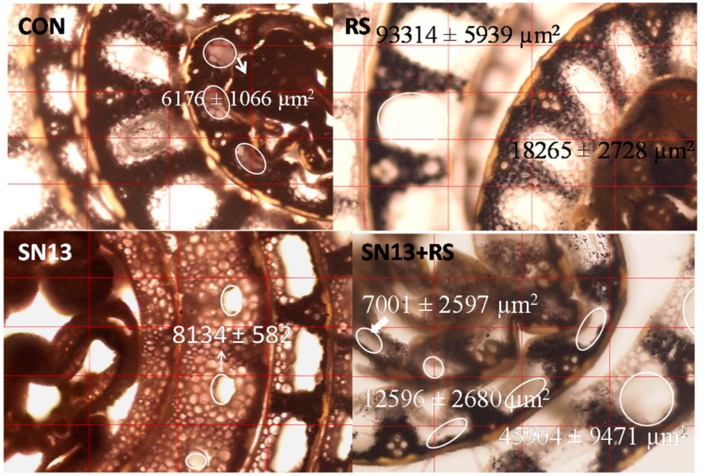
Stem cross section showing effect of B. amyloliquefaciens (SN13) on aerenchyma formation in rice, 15 dpi. “First’ and ‘second’ indicate the sheath layer from core and the encircled area shows the extent of aerenchyma formation. CON, control; SN13, biocontrol agent; R. solani, pathogen; dpi, days post infection. Magnification 40×.